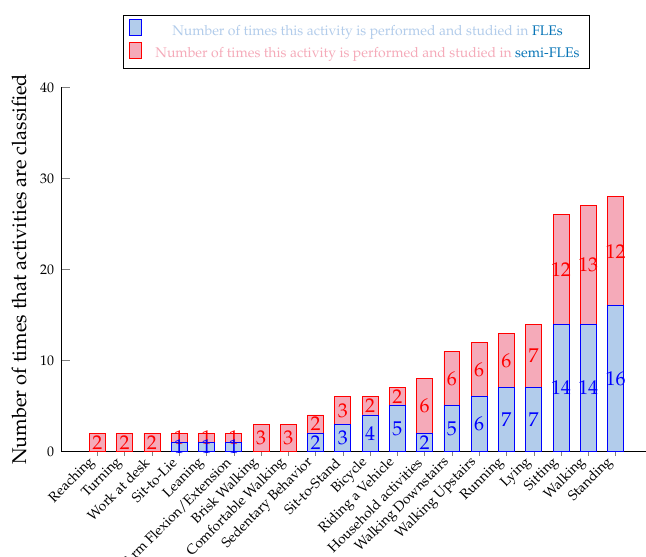
Figure 10. Details of the distribution of the studied activity types into FLEs and semi-FLEs. Total Number of Activities performed an studied in FLEs = 84. Total Number of Activities performed and studied in Semi-FLEs =